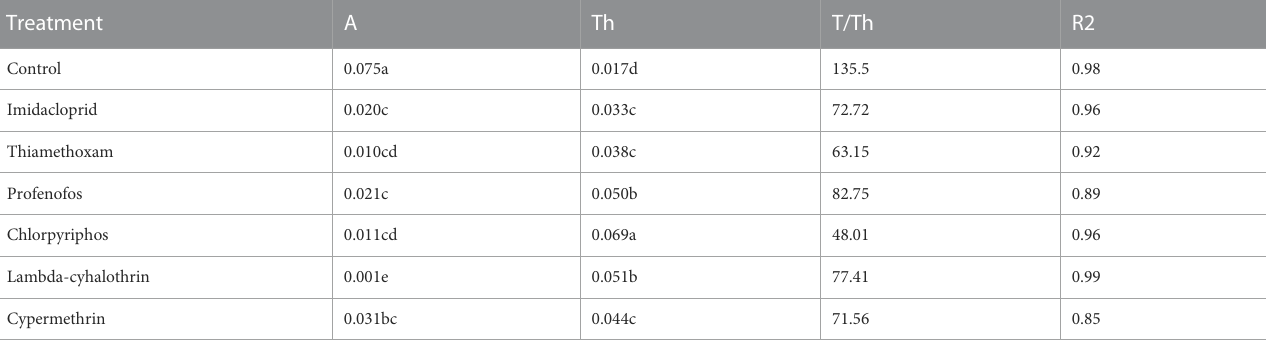
TABLE 3 Parameters for functional response model for adult Coccinella septempunctata exposed to sublethal concentrations (LC 30 ) of six insecticides.